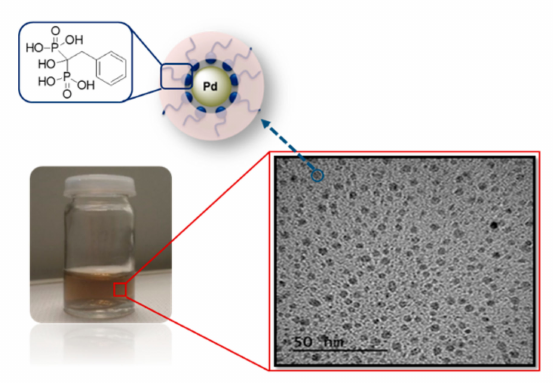
Figure 2. Structure of the Pd NPs used in the kinetic studies. Lower panel, right side: TEM micrograph of Pd-NPs solution (average diameter, 6 nm). The upper panel left side: Scheme of the Pd NPs consisting of spherical Pd with benzyl bisphosphonic acid as a ligand